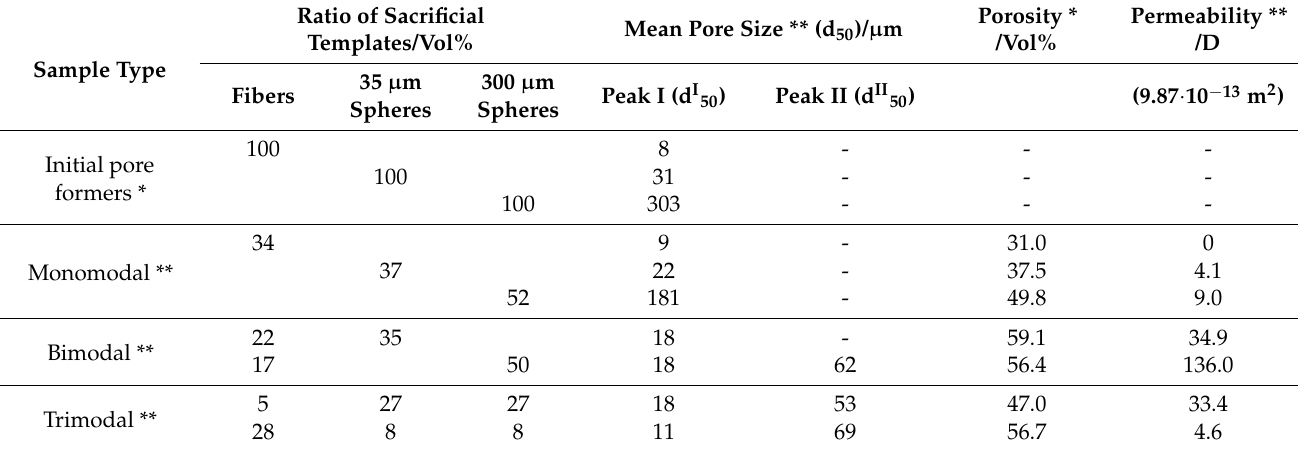
Table 2. µ -CT derived mean pore sizes (d 50 ) and corresponding permeability of the sintered Al 2 O 3 ceramics with represen- tative mono-, bi- and trimodal pore distributions in comparison to the initial pore former size. The monomodal pore size distributions are characterized by a single peak, while bi- and trimodal samples containing 300 µ m spheres exhibit bimodal pore size distributions (peak I and